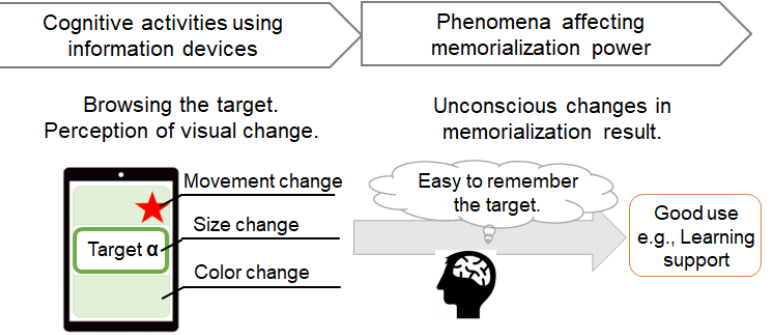
Figure 1. Hypothesis. Phenomenon of changes in memorization due to stimuli of modulating visual